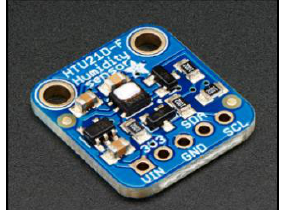
Figure 7. Humidity and Temperature Sensor (Model: HTU21D- F by Adafruit)